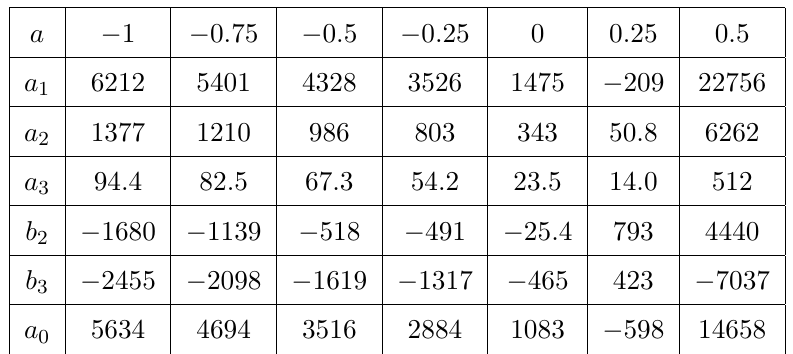
Table 5 . Results for the (cid:12)t coe(cid:14)cients in eq. (3.24) obtained from the EVENT2 data displayed in (cid:12)gure 8. The uncertainties on these (cid:12)ts are illustrated in the plots on the right panel of (cid:12)gure 8. shown gives a negligible shift in the extracted (cid:12)t parameters in eq. (3.24). The errors